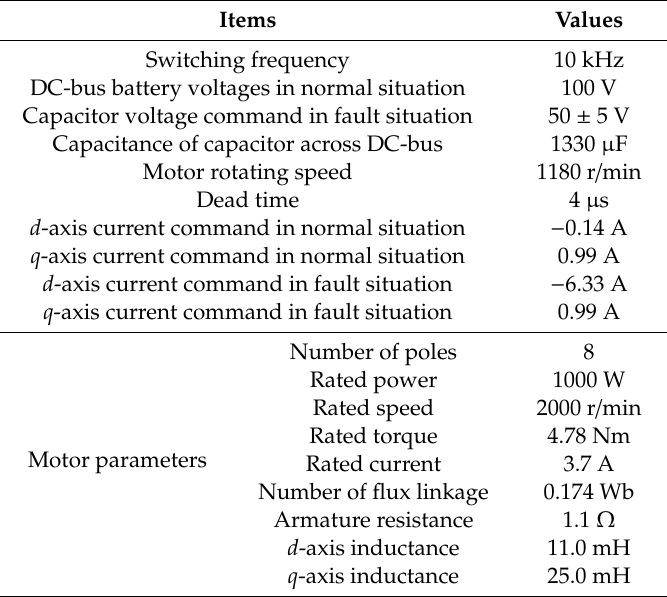
Figure 12. Experimental setup. Table 2. Experimental conditions.